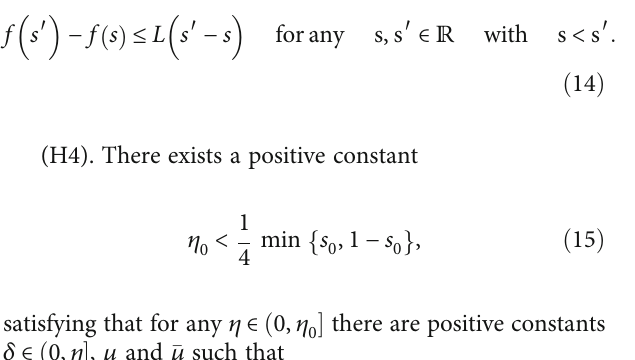
Figure 1: Planar wave U ð x